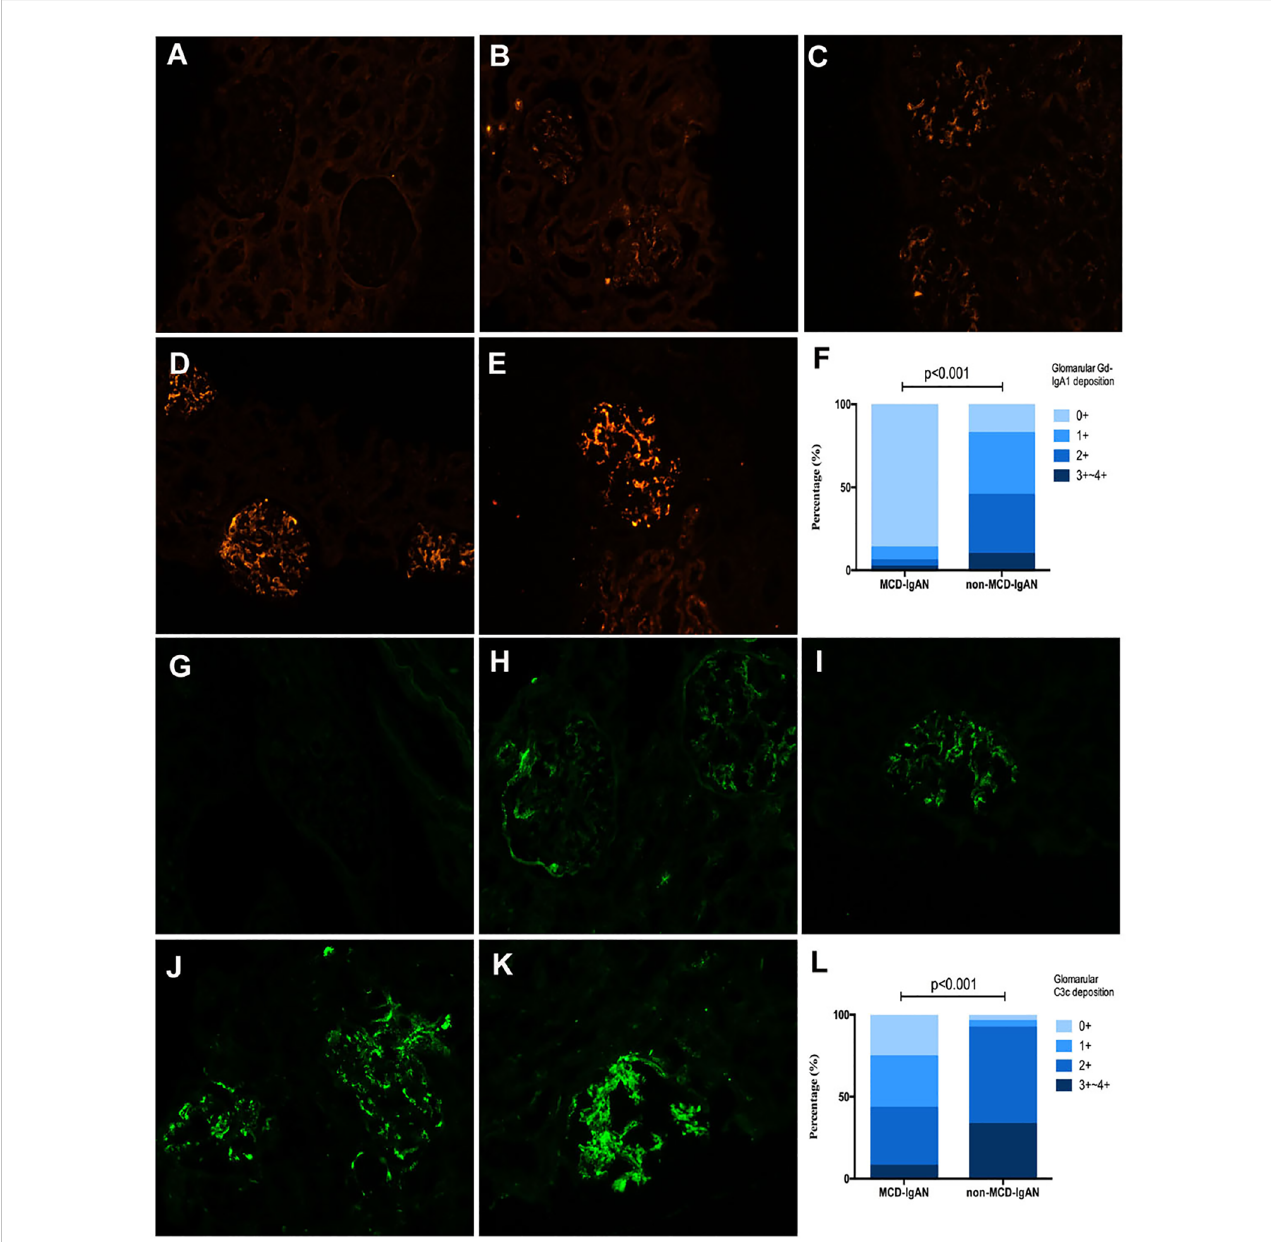
FIGURE 2 Representative pictures of immuno fl uorescence staining of mesangial galactose-de fi cient immunoglobulin A1 (Gd-IgA1) and C3c 0 to 4+ in patients with immunoglobulin A nephropathy (IgAN). Granular-positive staining of Gd-IgA1 (A – E) and C3c (G – K) by immuno fl uorescencealong the glomerular mesangial and capillary area in patients with IgAN. (A, G) negative; (B, H) 1+ intensity; (C, I) 2+ intensity; (D, J) 3+ intensity, and (E, K) 4+ intensity. (A – E, G – K) : original magni fi cation ×200. (F) The intensity of Gd-IgA1 deposition in the glomerular mesangial and capillary areas was weaker in the minimal change disease (MCD)-IgAN group than in the non-MCD-IgAN group. (L) The intensity of C3c deposition in the glomerularmesangial and capillary areas was also weaker in MCD-IgAN group than in the non-MCD-IgAN